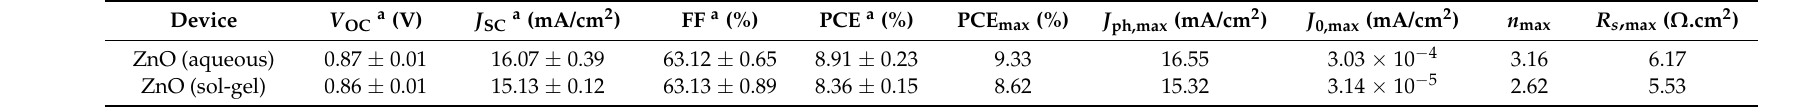
Table 1. Performance parameters of inverted OSCs on glass